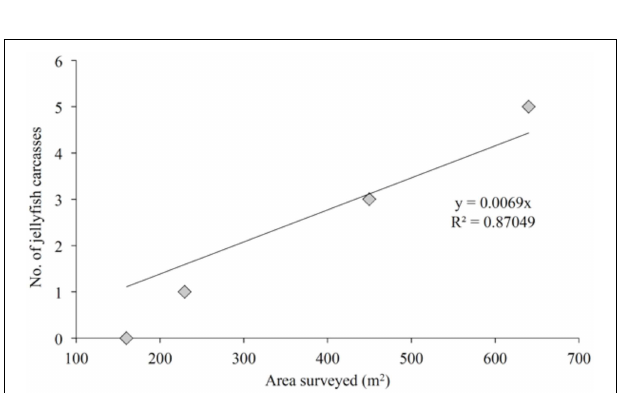
FIGURE 3 | The number of jelly-falls documented at the seafloor as a function of seafloor area photographed. The linear trend-line intercept is set to 0,0. Only the fjord basin transects (447m depth) were